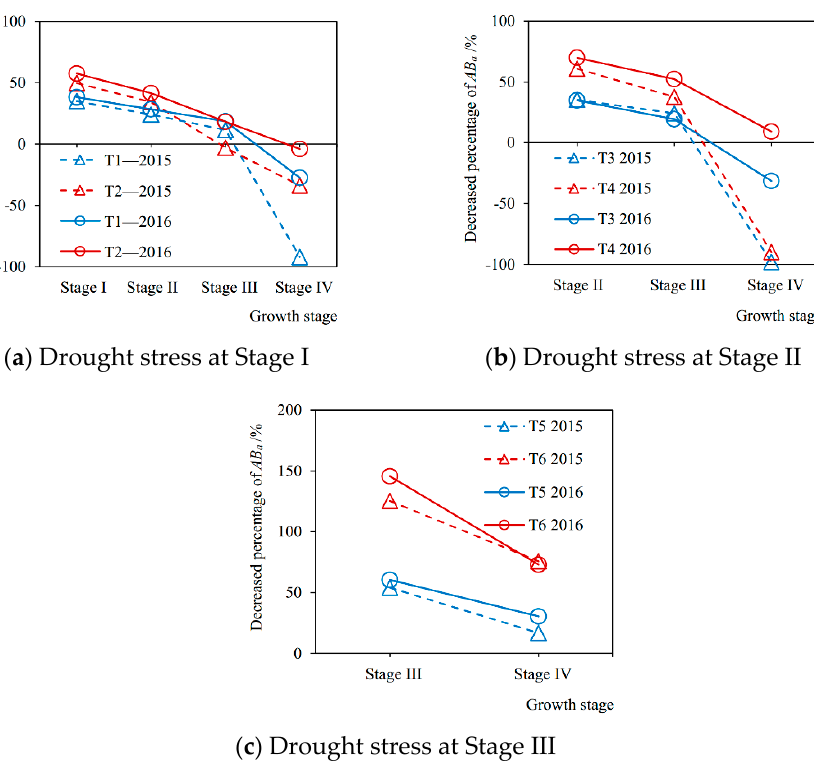
Figure 6. The decreased percentages of soybean aboveground biomass accumulation ( AB a ) during each growth stage caused by drought stress at ( a ) Stage I, ( b ) Stage II, and ( c ) Stage III, respectively, compared with sufficient irrigation in the 2015 and 2016 seasons. Stage I: seedling stage, Stage II: branching stage, Stage III: flowering-podding stage, Stage IV: seed filling stage. T1–T6: experimental treatments.